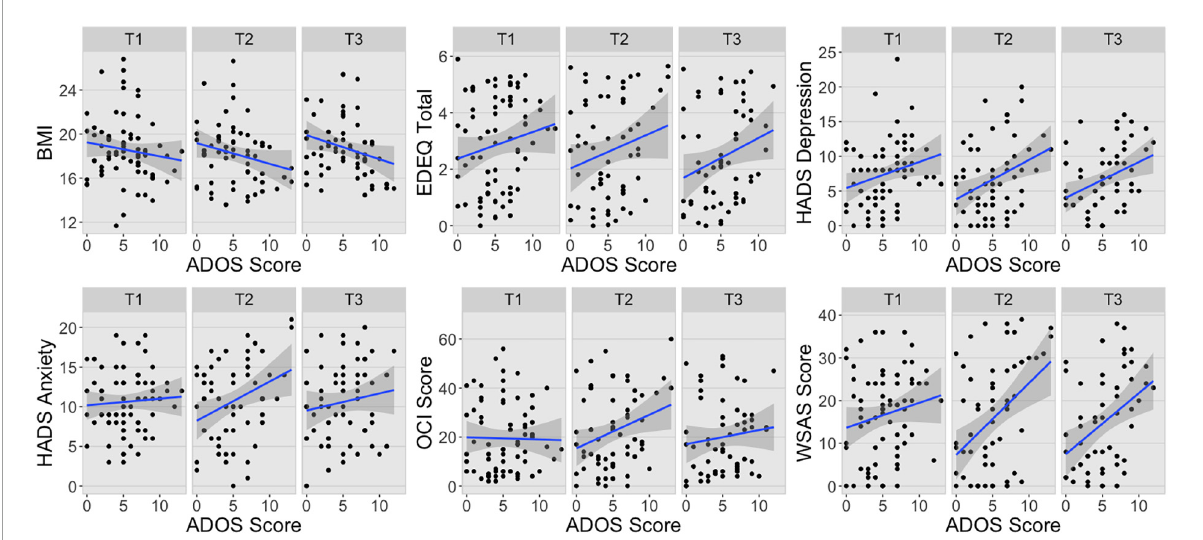
FIGURE1 Associations between ADOS scores and ED symptom profile measures at each time point. BMI, body mass index; EDEQ, Eating Disorder Examination Questionnaire; HADS, Hospital Anxiety and Depression Scale; OCI, Obsessive-Compulsive Inventory; WSAS, Work and Social Adjustment Scale; T1, Time 1; T2, Time 2; T3, Time 3.